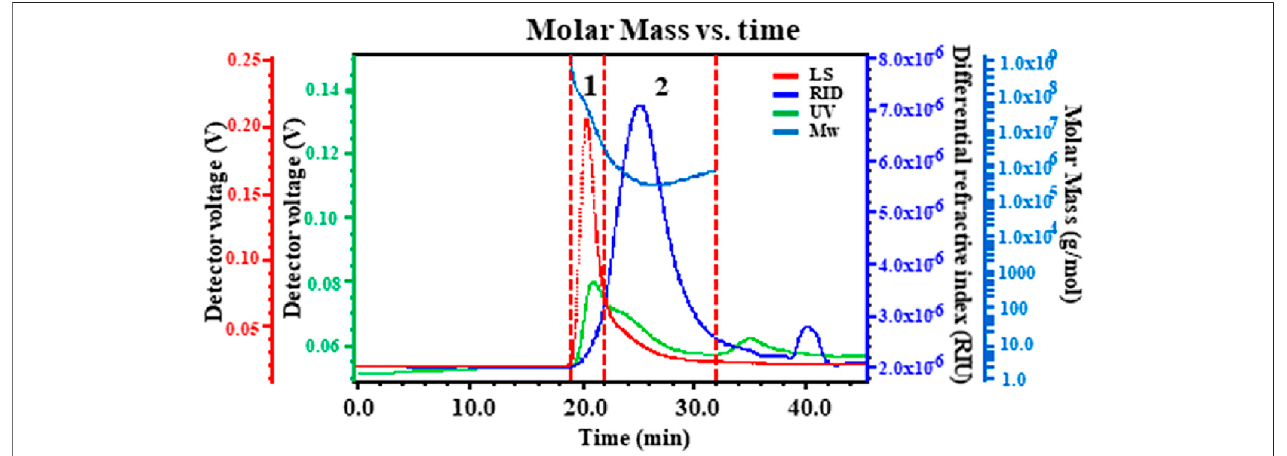
FIGURE 1 | Typical high-performance size exclusion chromatography (HPSEC) of Punica granatum peel polysaccharides (PPPs).